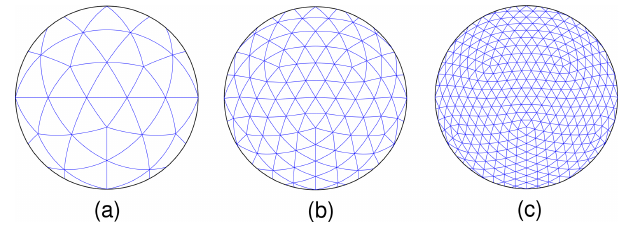
Figure 2. Dual (triangular) grids of the grids shown in Fig. 1 for 12 (a) , 42 (b) and 162 (c)